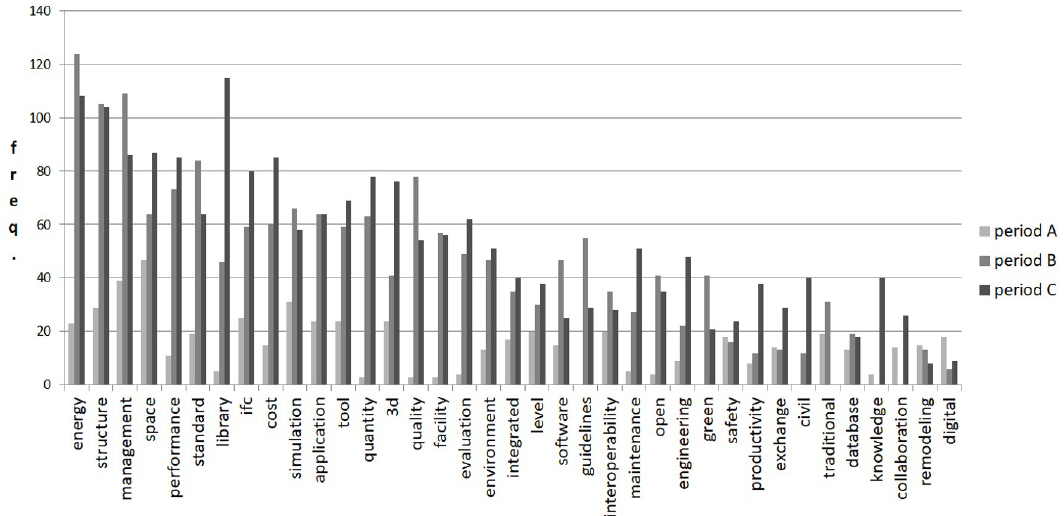
Figure 4. Time-frequency analysis graph